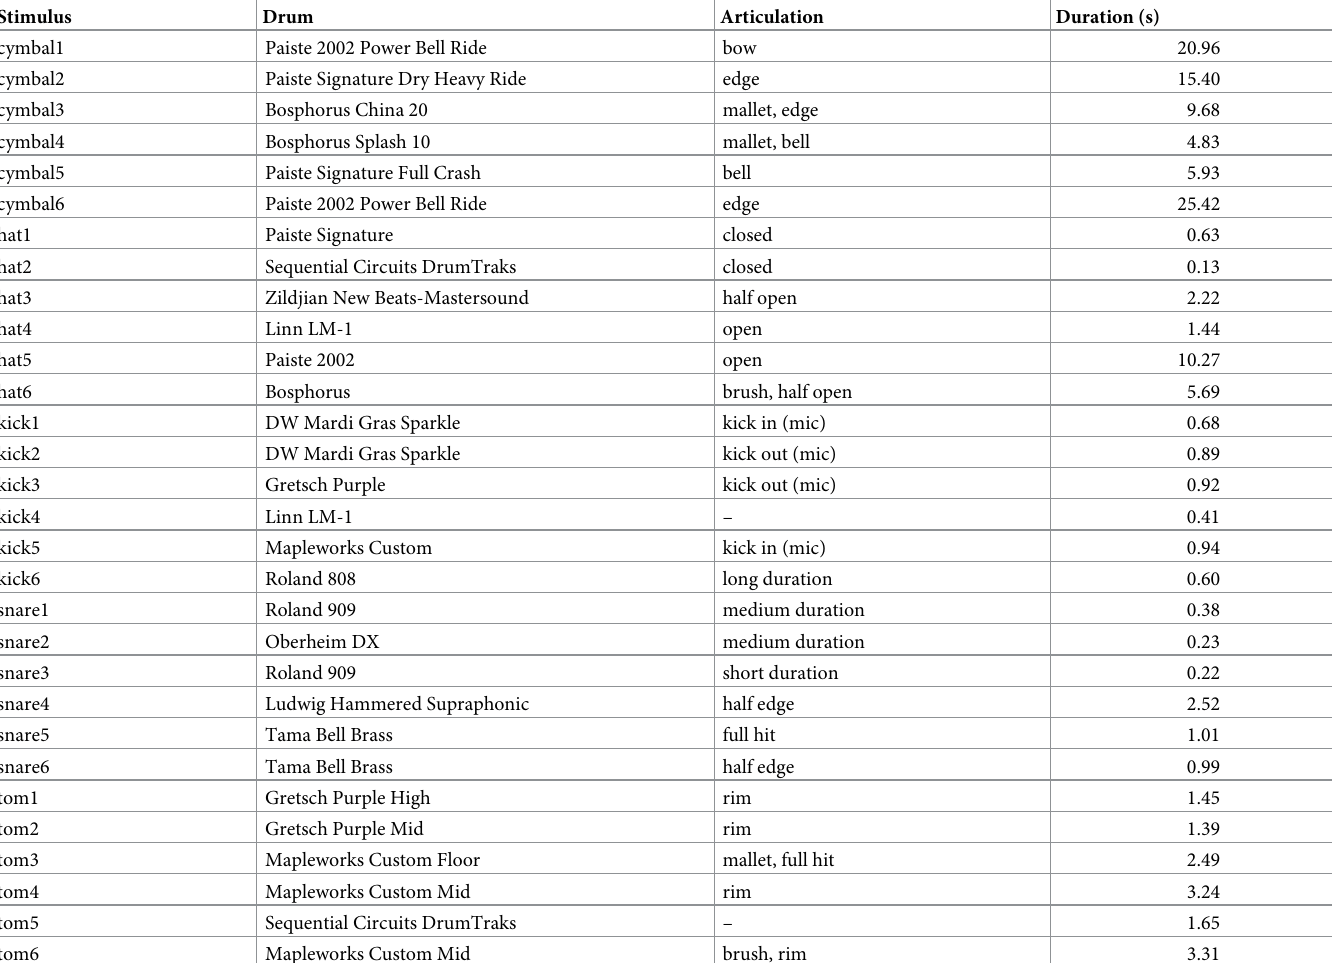
Table 1. Selected drum samples used as stimuli for the vocal imitations. Descriptions and articulations are taken from the sample library documentation and are not exhaustive desciptions of the recording setup, strike style or drum machine settings etc. Unless specified otherwise the acoustic drums were struck with a